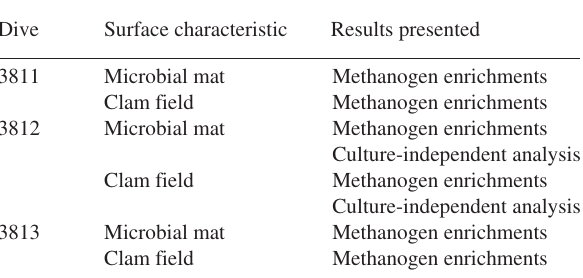
Table 1. Sites sampled in various